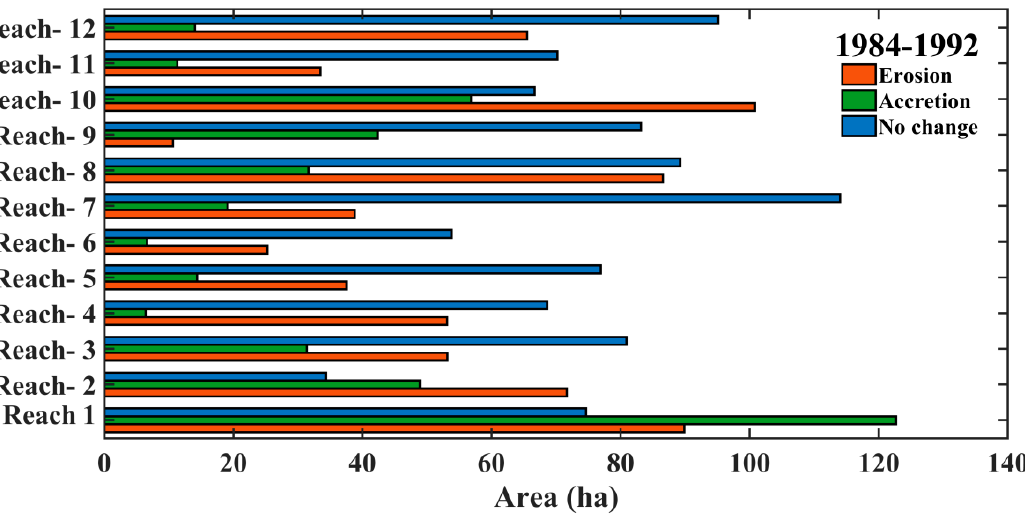
Figure 6. Erosion, accretion, and unchanged area at various reaches (1–12) between 1984 and 1992.